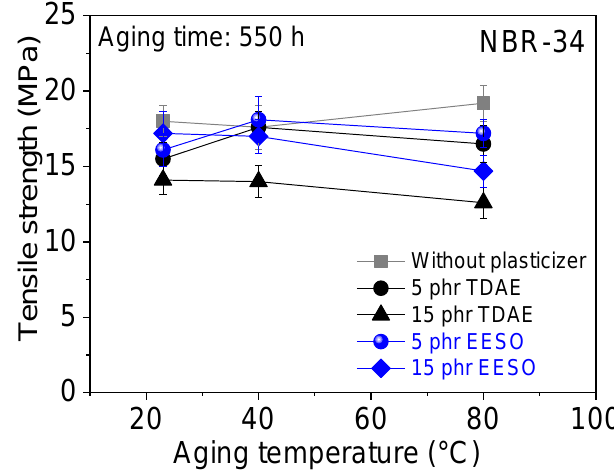
Figure 14. Dependence of tensile strength on aging temperature for NBR-34 vulcanizate with various plasticizers.